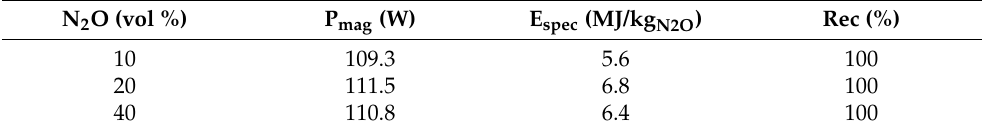
Table 7. Energy consumption and recovery percentage of the microwaves–assisted TSA